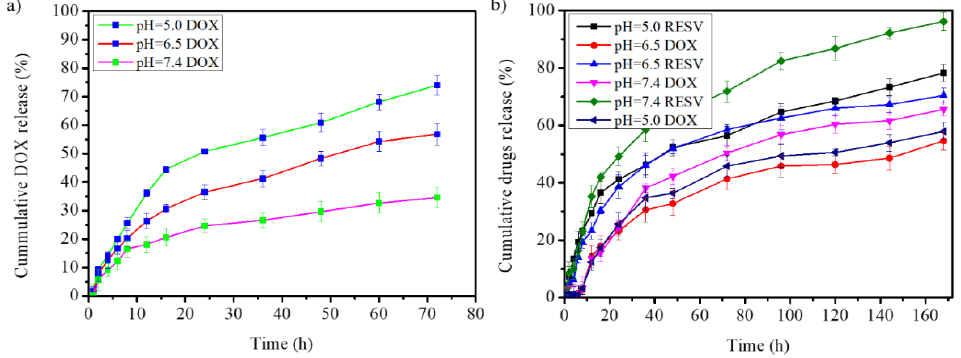
Figure 7. Cumulative drug release from ( a ) G4.5-DOX (DOX encapsulated in the G4.5